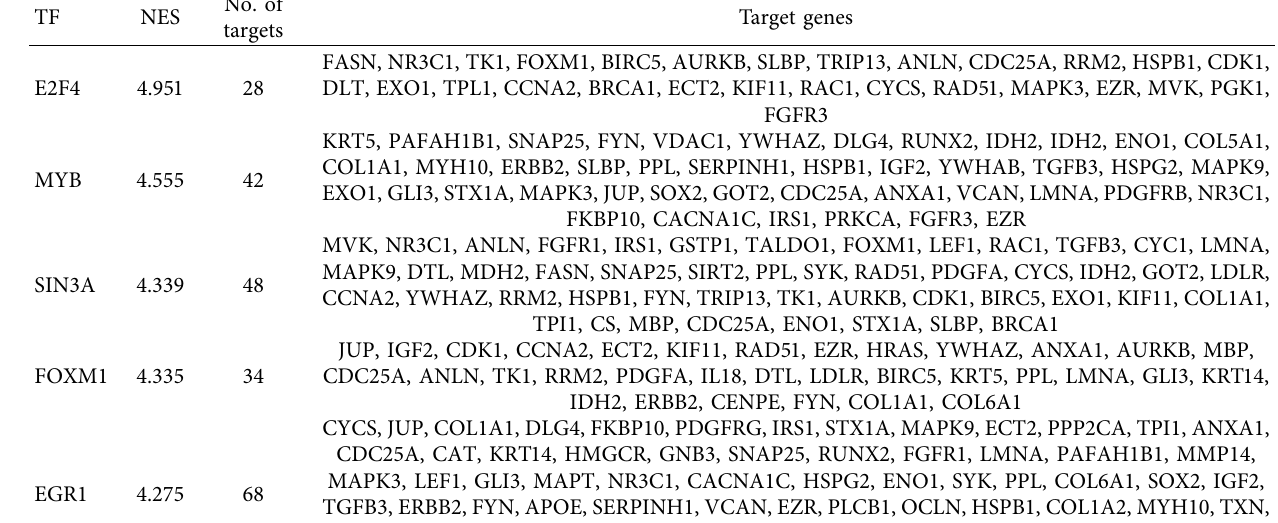
Table 2: A total of 17 transcription factors acting on the hub genes in primary